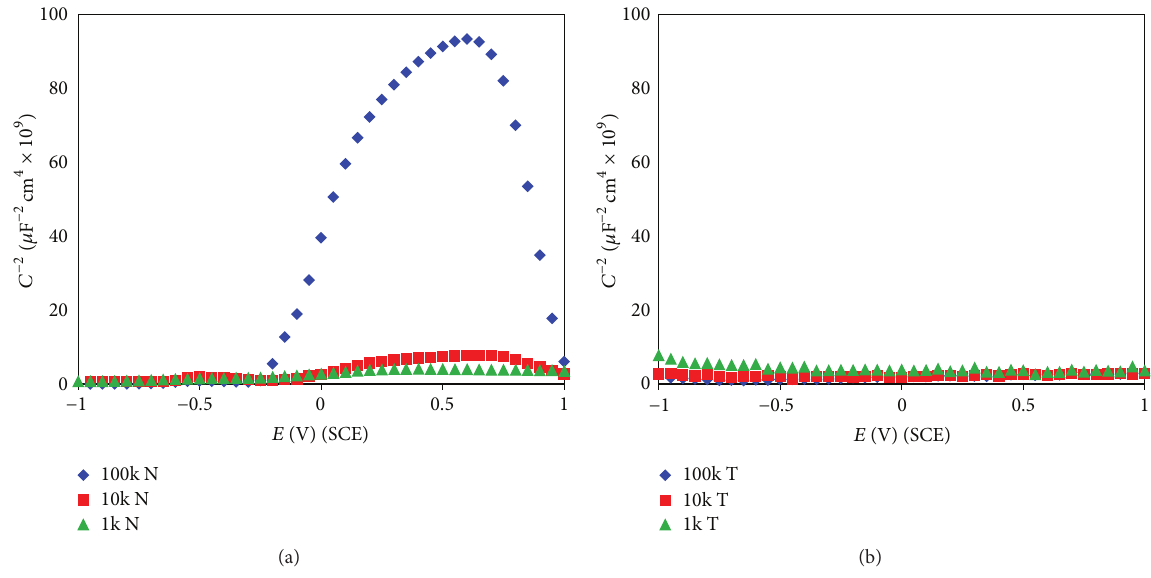
Figure 4: Effect of corrosion inhibitors (N: NO 2− , T: TEA) on Mott-Schottky plot for the passive film formed at 0 V (SCE) in deaerated tap water at 30 ∘ C. (a) Nitrite addition. (b) TEA